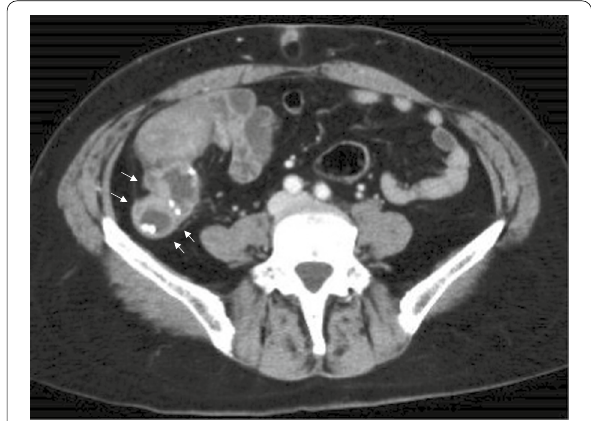
Fig. 2 Axial images of contrast-enhanced computed tomography showing an irregular appendix (white arrows) swelling and thickening of the appendix wall with cystic dilation. Calcified lesions are also found inside the appendix